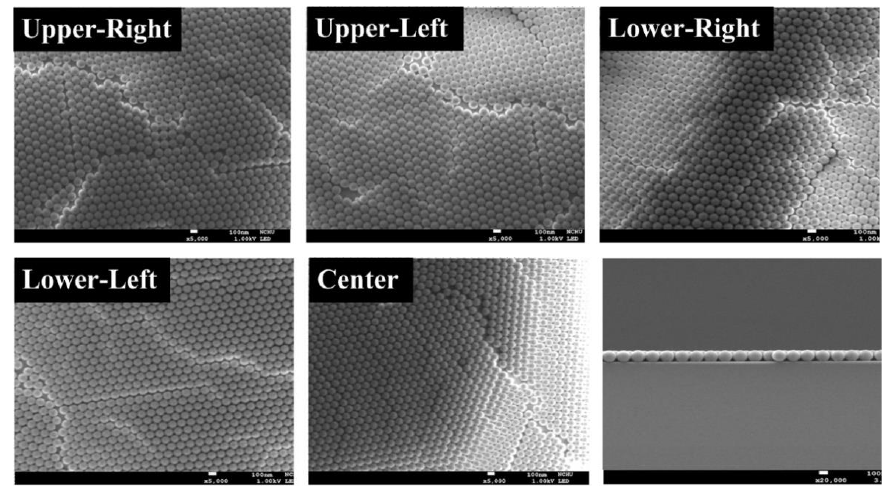
Figure 2. SEM images of PS NS array with diameters of 100, 200 and 500 nm under ( a ) the high spin speed, ( b ) the low spin speed, and ( c ) high volume of the droplet of PS NS colloidal suspension from the pipette (13